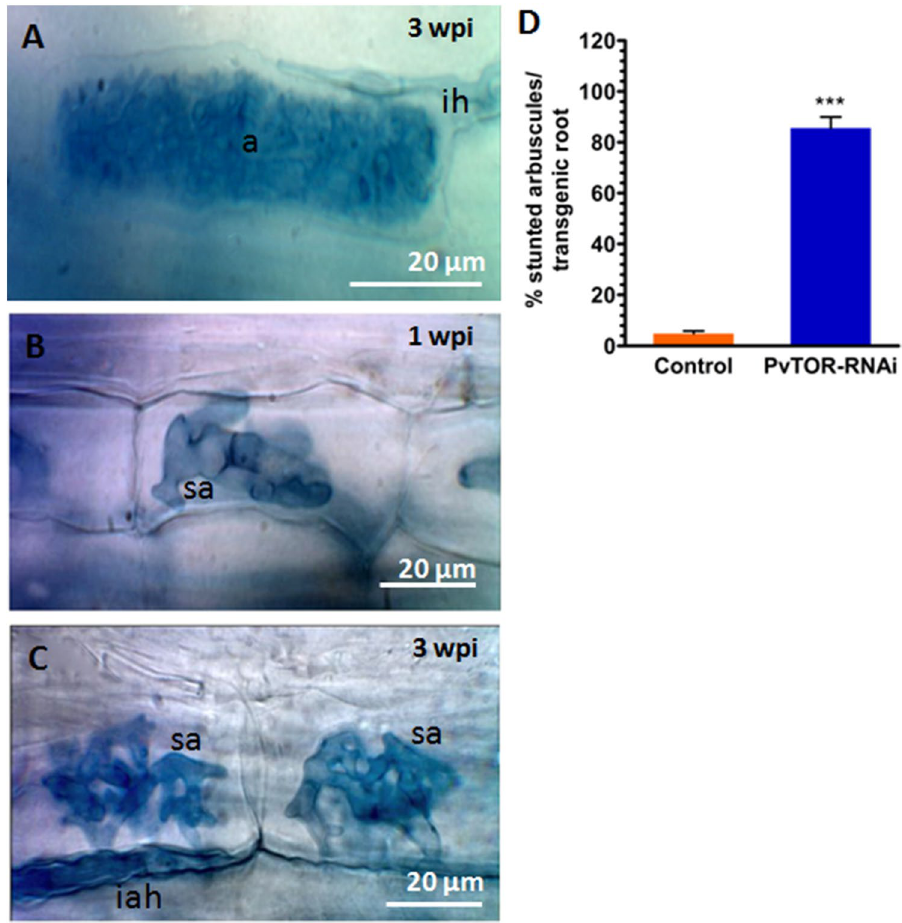
Figure 6. Arbuscular mycorrhizal phenotype of P. vulgaris PvTOR -RNAi roots colonized by R. irregularis . ( A ) The arbuscules in the cortex cells of the control transgenic roots are well developed. ( B–C ) Stunted arbuscules in the cortex cells of the PvTOR -RNAi transgenic roots at 1 wpi and 3 wpi, respectively. ( D ) Quantification of stunted arbuscules per transgenic control and PvTOR -RNAi roots at 3 wpi. The statistical significance of differences between control and PvTOR -RNAi roots was determined using an unpaired two-tailed Student’s t -test (*** P < 0.001). Error bars refer to the SD of the mean of three biological replicates (n > 30 for D). a, arbuscule; ih, intercellular hyphae; sa, stunted arbuscule, iah, intracellular hyphae; wpi, week(s) post inoculation, Ri, R. irregularis